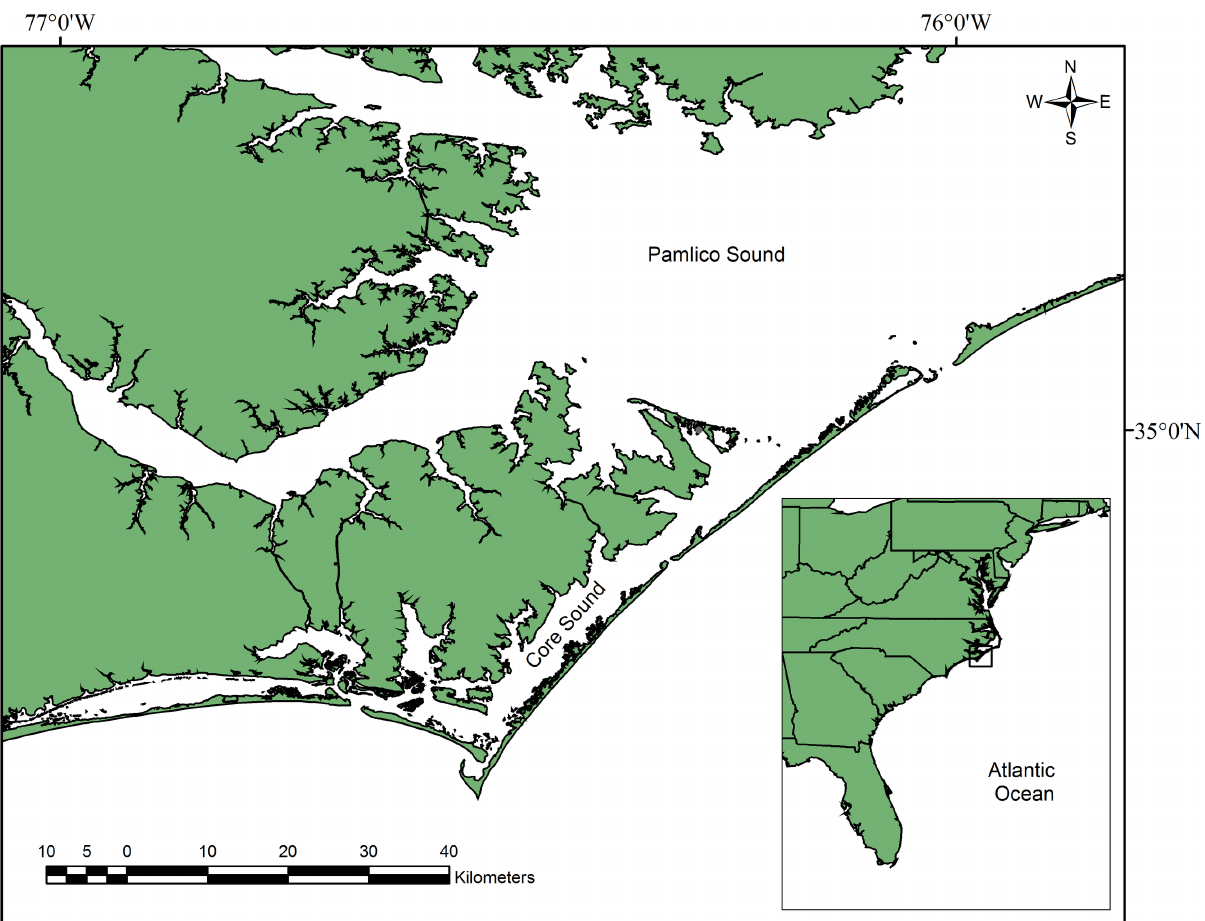
Fig 1. Map of study area where juvenile loggerhead ( Caretta caretta ) sea turtles were captured in pound nets and long haul seines fished in Core and Pamlico Sounds, North Carolina, USA, June to August, 1998 – 2007.